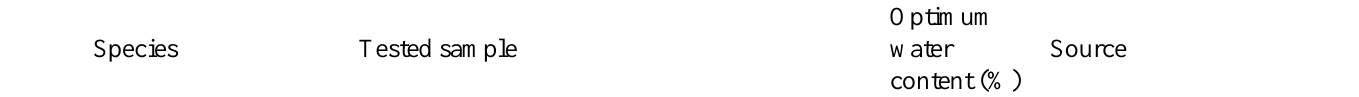
Table 3. Optimum water content for photosynthesis in Sphagnum species from our study and global literature.